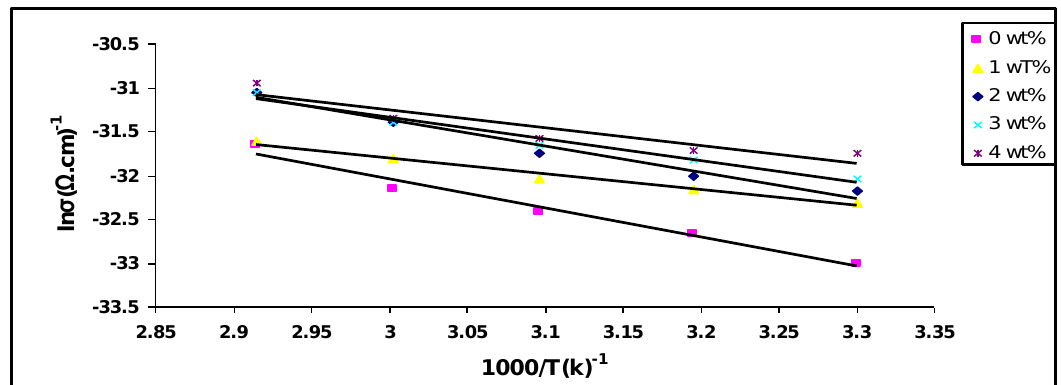
(Ω.cm) -1 with the temperature. v